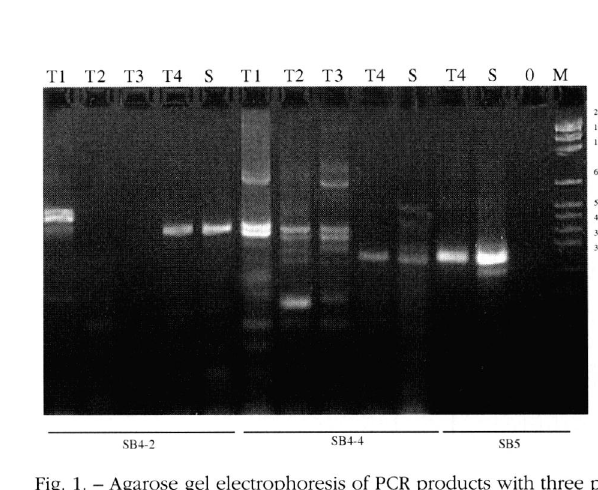
Fig. 1. - Agarose gel electrophoresis of PCR products with three pri mers: SB4-2, SB4-4 and SB5. T1- 4 reference strains, T. spiralis (ISS004), T. nativa (ISS042), T. britovi (ISS100) and T. pseudospiralis (ISS013). S represents sample, 0 is negative control H 2 0, and M is molecular weight marker in bp.